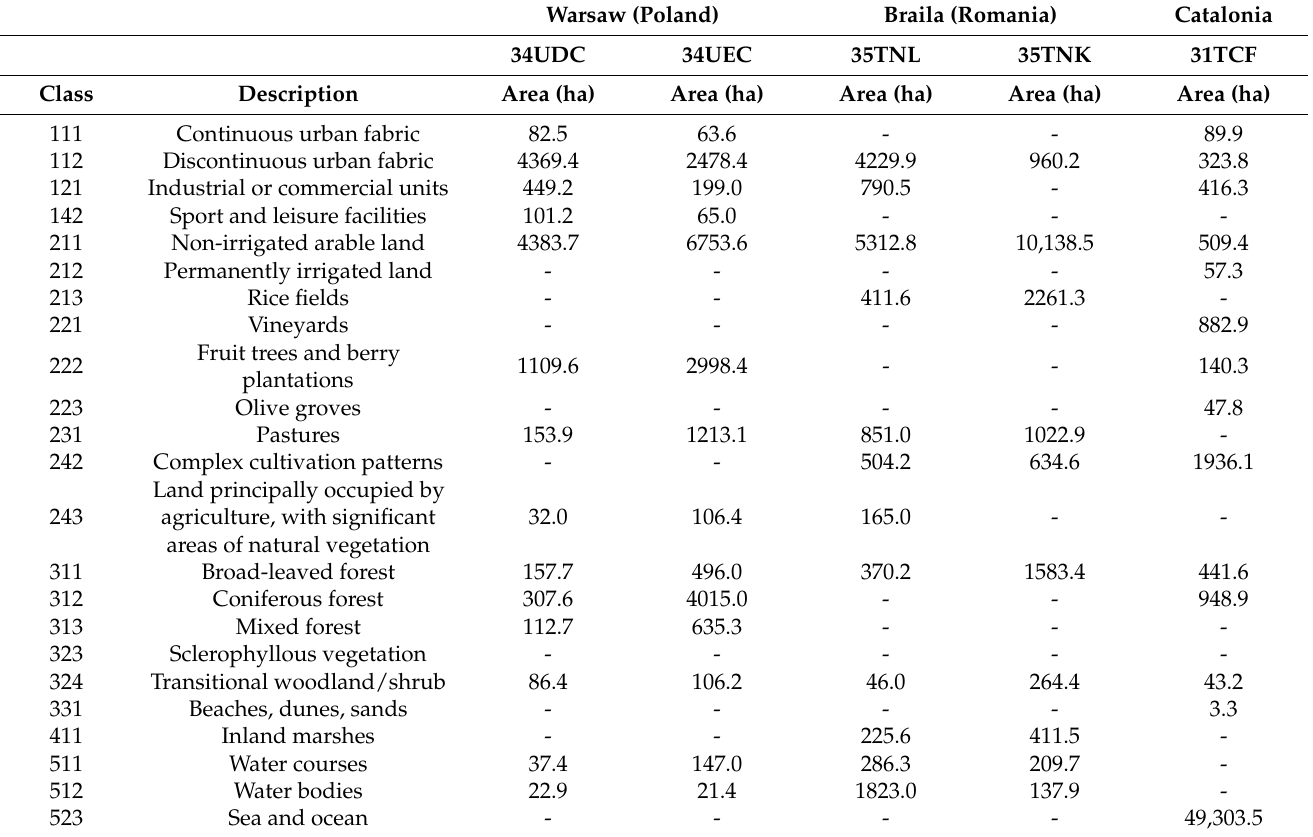
Table 3. Used areas for testing, training, and